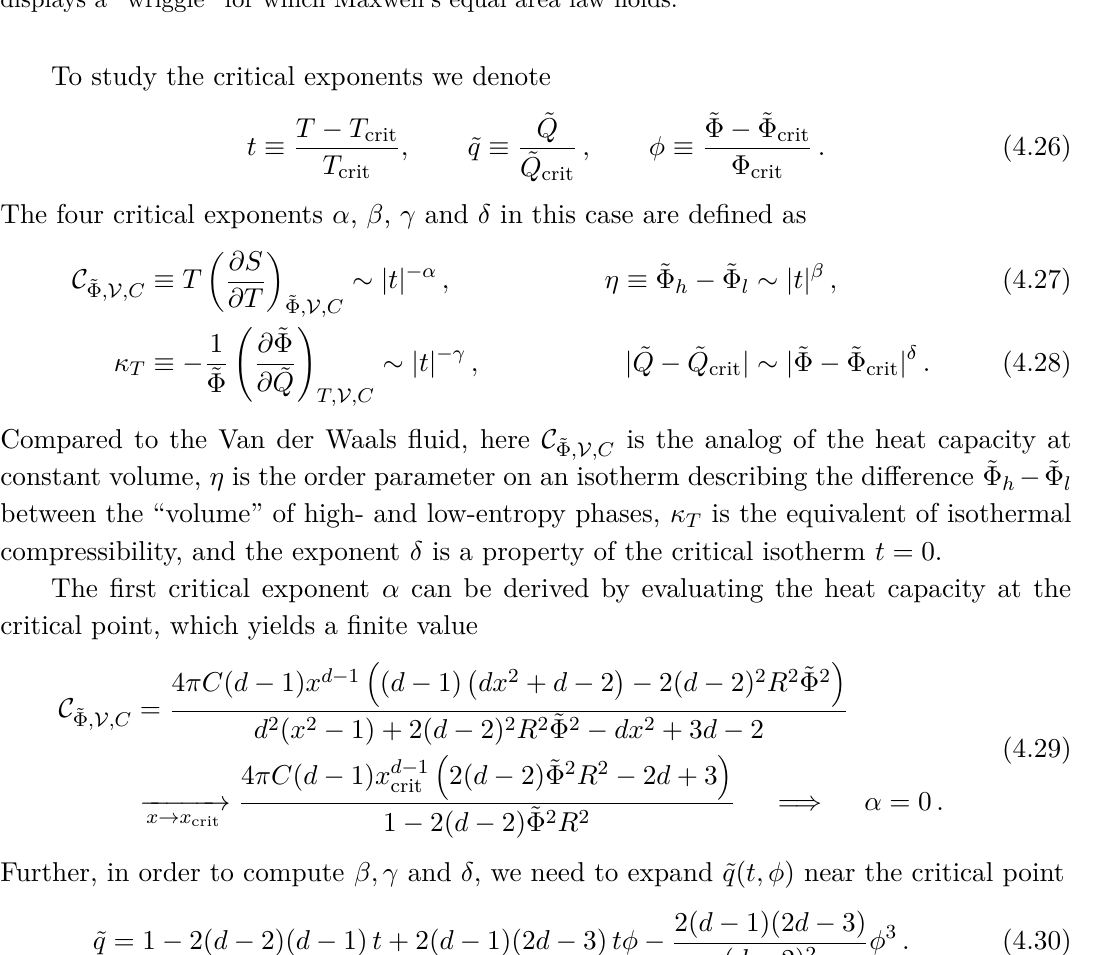
d = 4 . The √ (blue), T = T = 4 (orange), 3 crit crit 5 π (˜Φ) curve ˜ Q